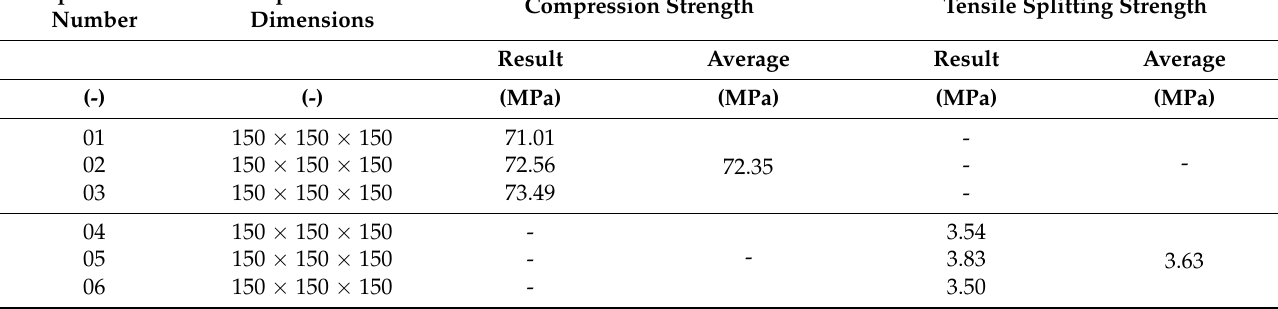
Table 3. Basic strength properties of the concrete.